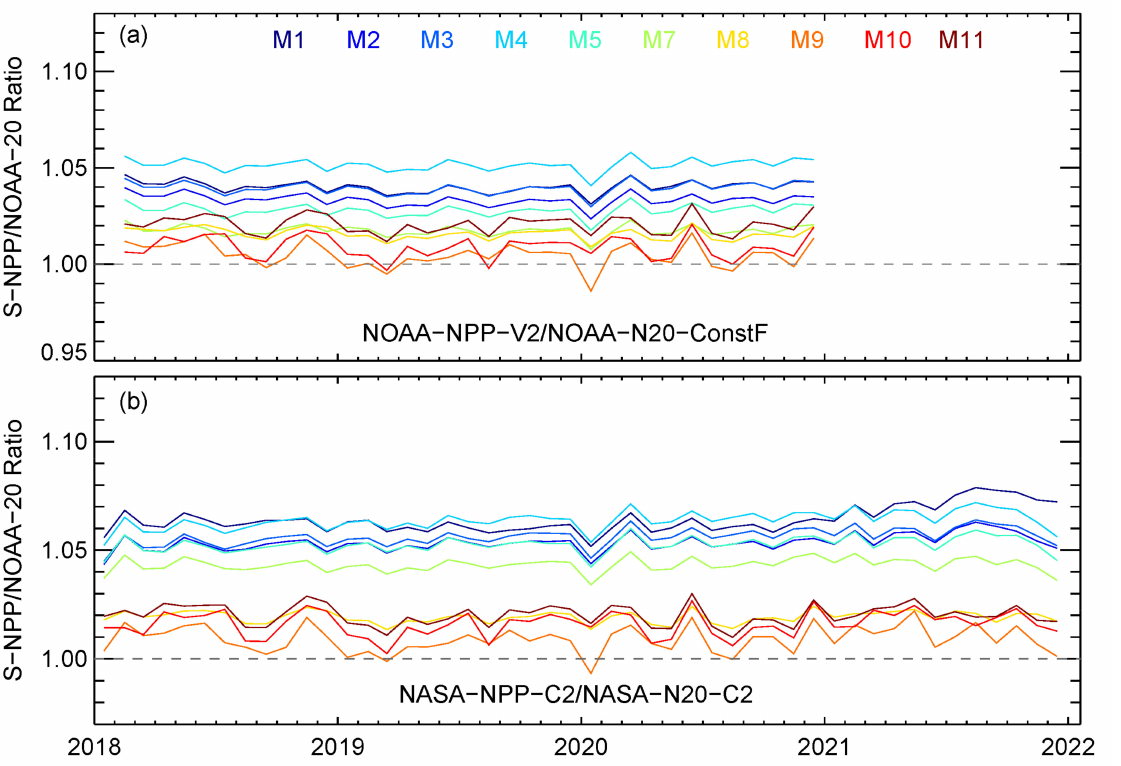
Figure 8. NOAA-20 and S-NPP VIIRS inter-satellite biases: ( a ) NOAA-NPP-V2/NOAA-N20-ConstF and ( b )